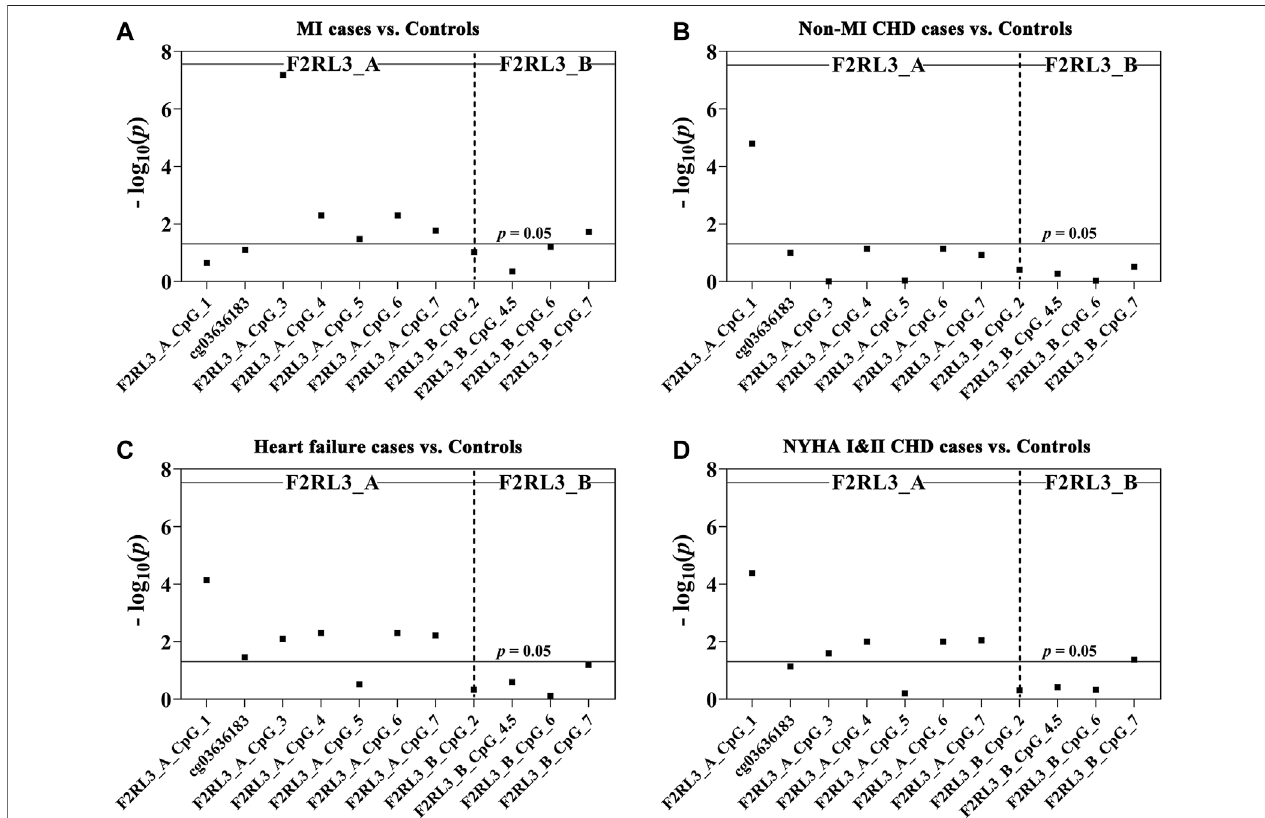
FIGURE2| Theassociationbetweendecreased F2RL3 methylationintheperipheralbloodandMIcases,non-MICHDcases,heartfailurecases,andpatientswith minor to medium cardiac function impairment (NYHA Ⅰ & Ⅱ CHD cases). The point plots show the methylation differences of CpG sites in the amplicon of F2RL3_A and F2RL3_B (A) between 184 controls and 78 MI cases, (B) between 184 controls and 102 non-MI CHD cases, (C) between 184 controls and 145 heart failure cases, (D) between 184 controls and 124 NYHA Ⅰ & Ⅱ CHD cases. The p -values of all the 12 measurable CpG loci in the two amplicons were calculated by logistic regression adjustedforage,gender,smoking,hypertension,TC,LDL,andbatcheffect.Theverticaldashedlineseparatesthetwoamplicons.Thesolidlinesindicatethethresholds of p -value = 0.05.